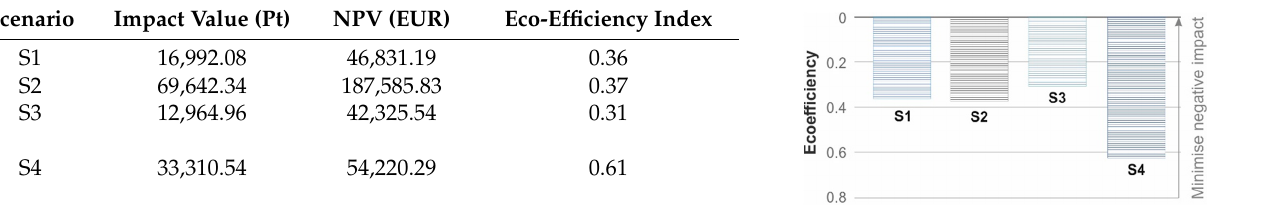
Table 10. Eco-efficiency analysis for lighting scenarios.